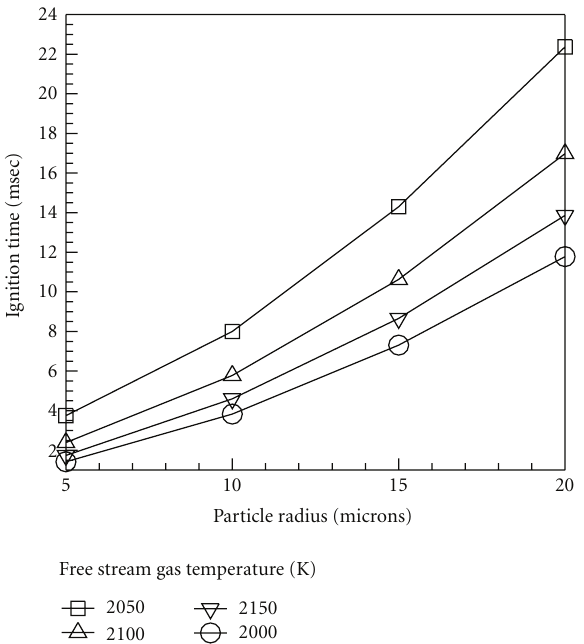
Figure 7: Ignition time versus particle radius for various ambient gas temperatures.